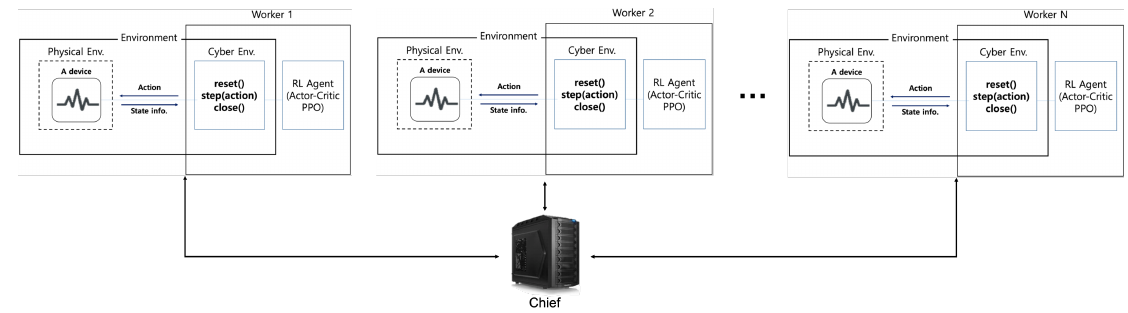
Figure 1. The system configuration for the proposed federated reinforcement learning.